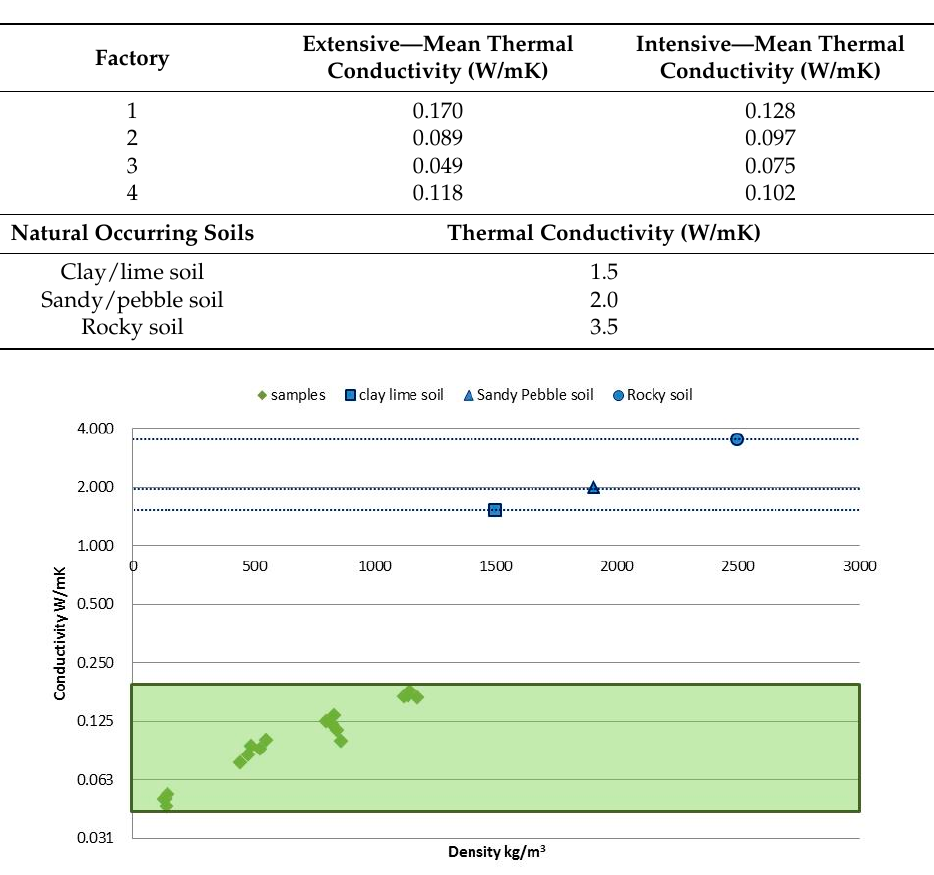
Figure 2. The green rectangle shows the growing media conductivity range, while the blue lines represent the natural soils conductivity values.